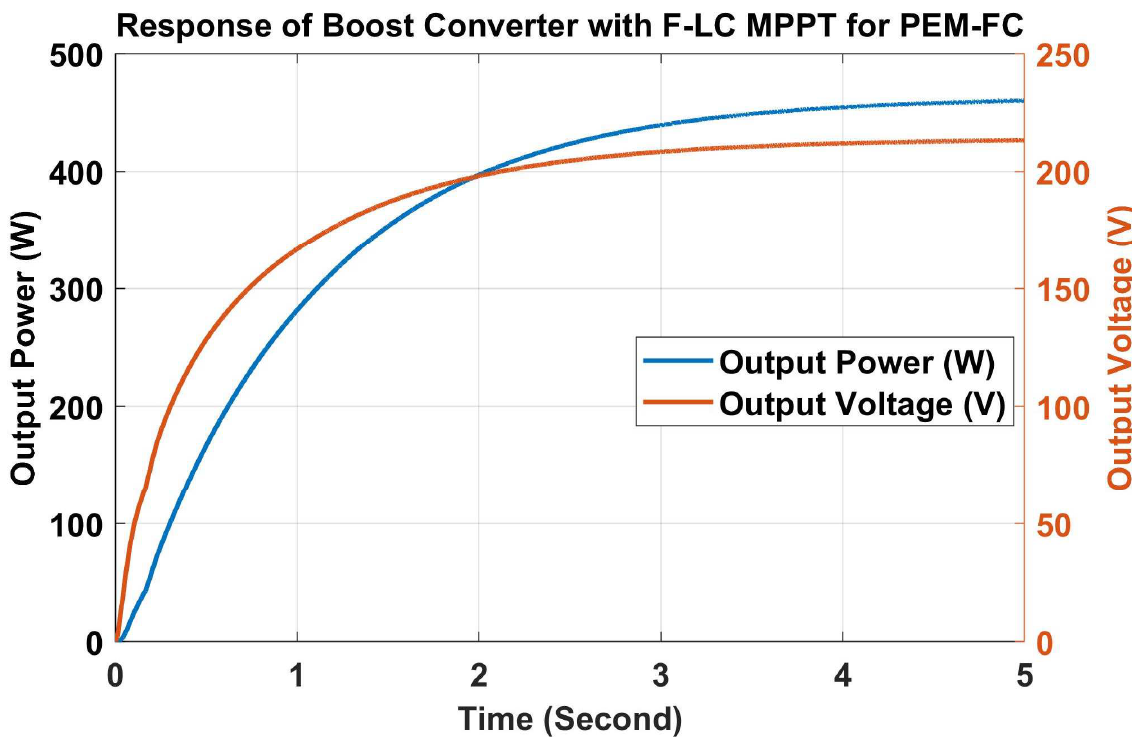
Figure 20. Output Power and Voltage of Boost Converter with F-LC MPPT for PEM-FC Framework.